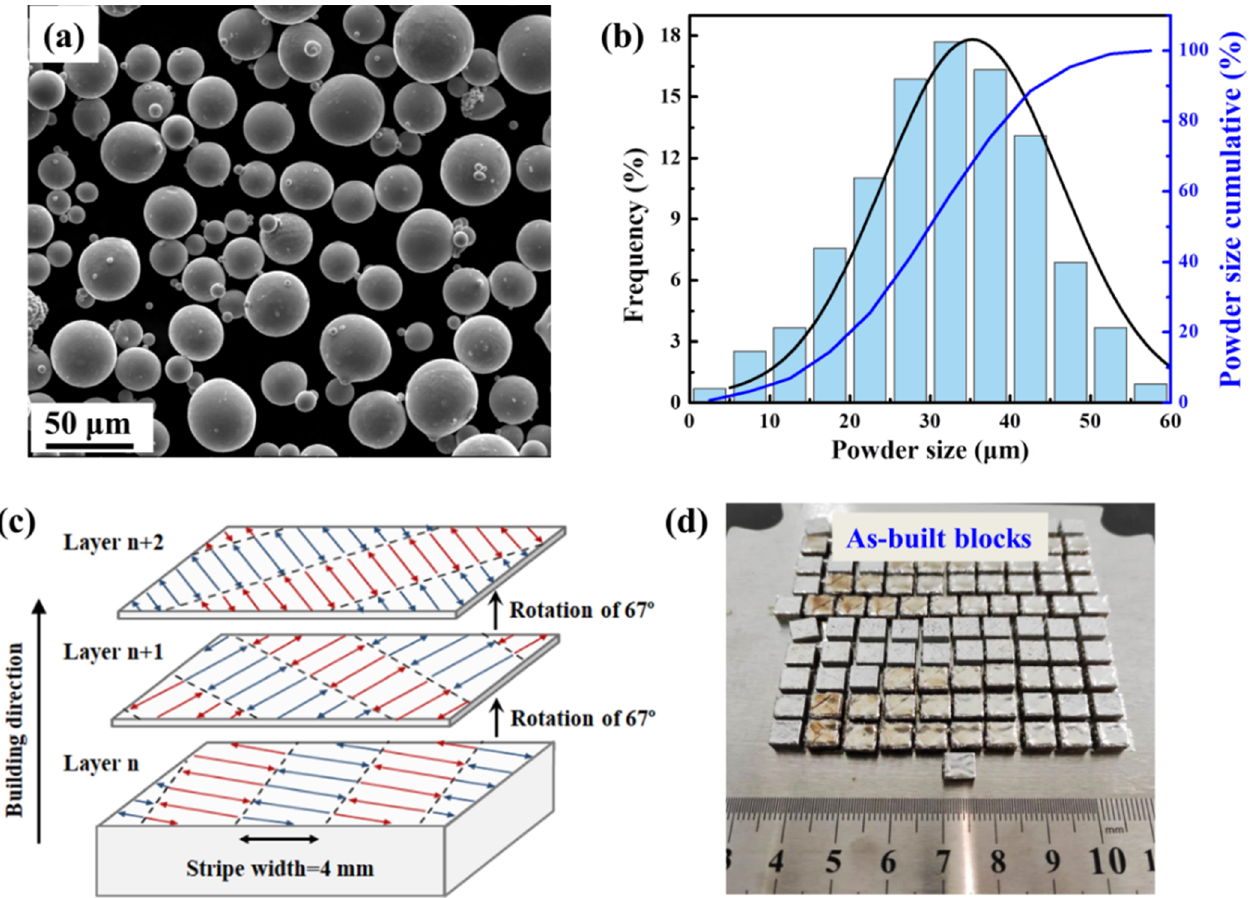
Figure 1. Powder characteristics include ( a ) Scanning electron microscopy (SEM) image and ( b ) statistic of size distribution; ( c ) schematic of the scanning strategy; ( d ) pictures of the SLM fabricated bulk 60NiTi.